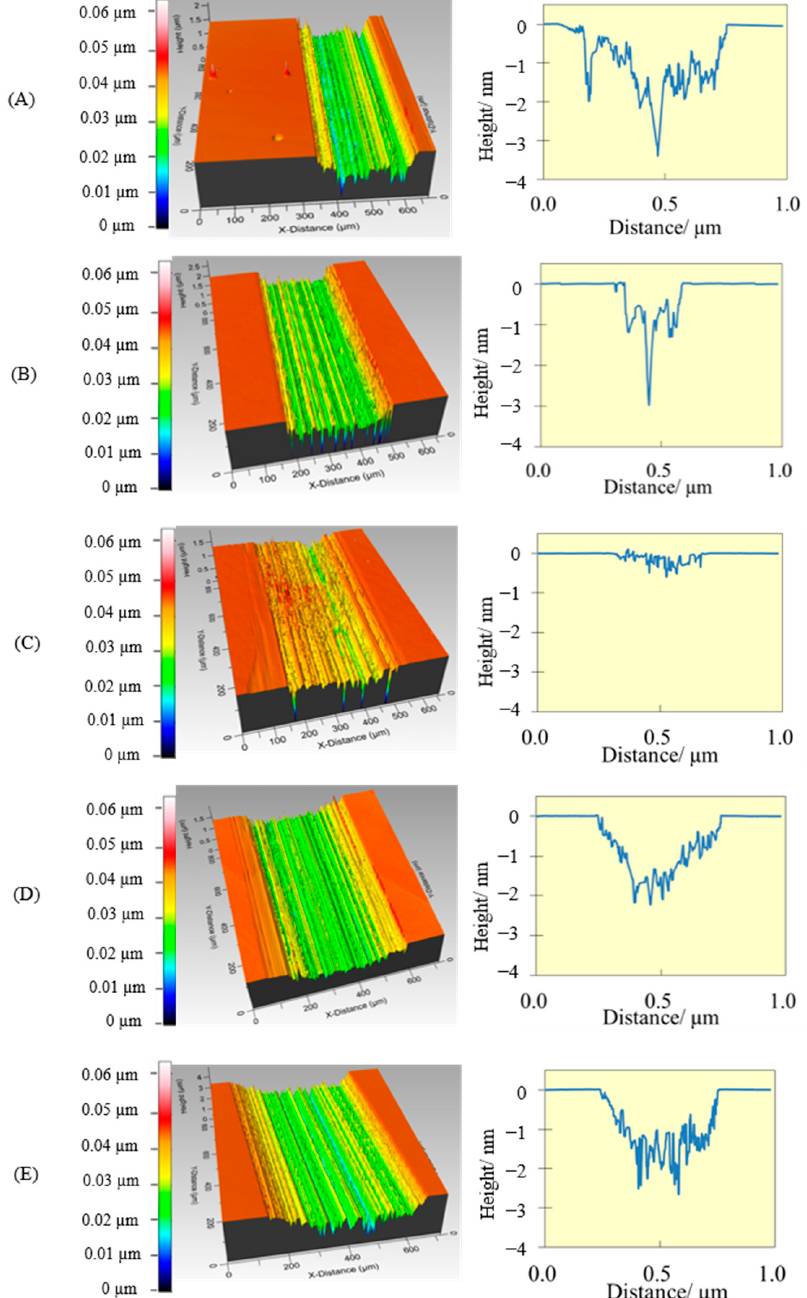
Figure 7. Wear tracks of the Si substrates (profilometer images with 20 × amplification) after long tribological tests under the load of 4 N using as lubricants: PEG200 ( A ), PEG200 + 2% [4-picH][MeSO 3 ] ( B ), PEG200 + 2% [4-picH][HSO 4 ] ( C ), PEG200 + 2% [DBUH][MeSO 3 ] ( D ) and PEG200 + 2% [DBUH][HSO 4 ] ( E ).